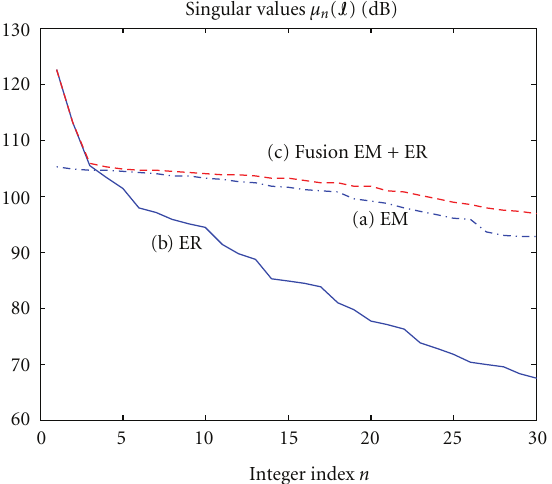
Figure 4: Singular values μ n ( I ) for the three di ff erent measurement scenarios. (a) Electromagnetic tomography with SNR (1) = 80dB. (b) Electrical resistive tomography with SNR (2) = 70dB. (c) Maximum likelihood-based data fusion with electromagnetic and electrical resistive tomography